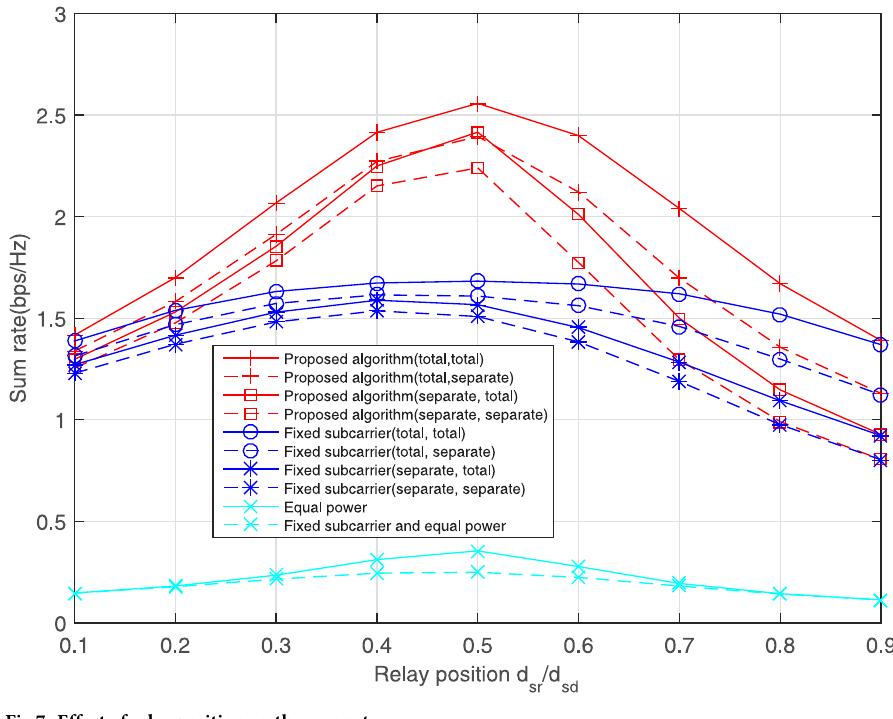
Fig 7. Effect of relay position on the sum